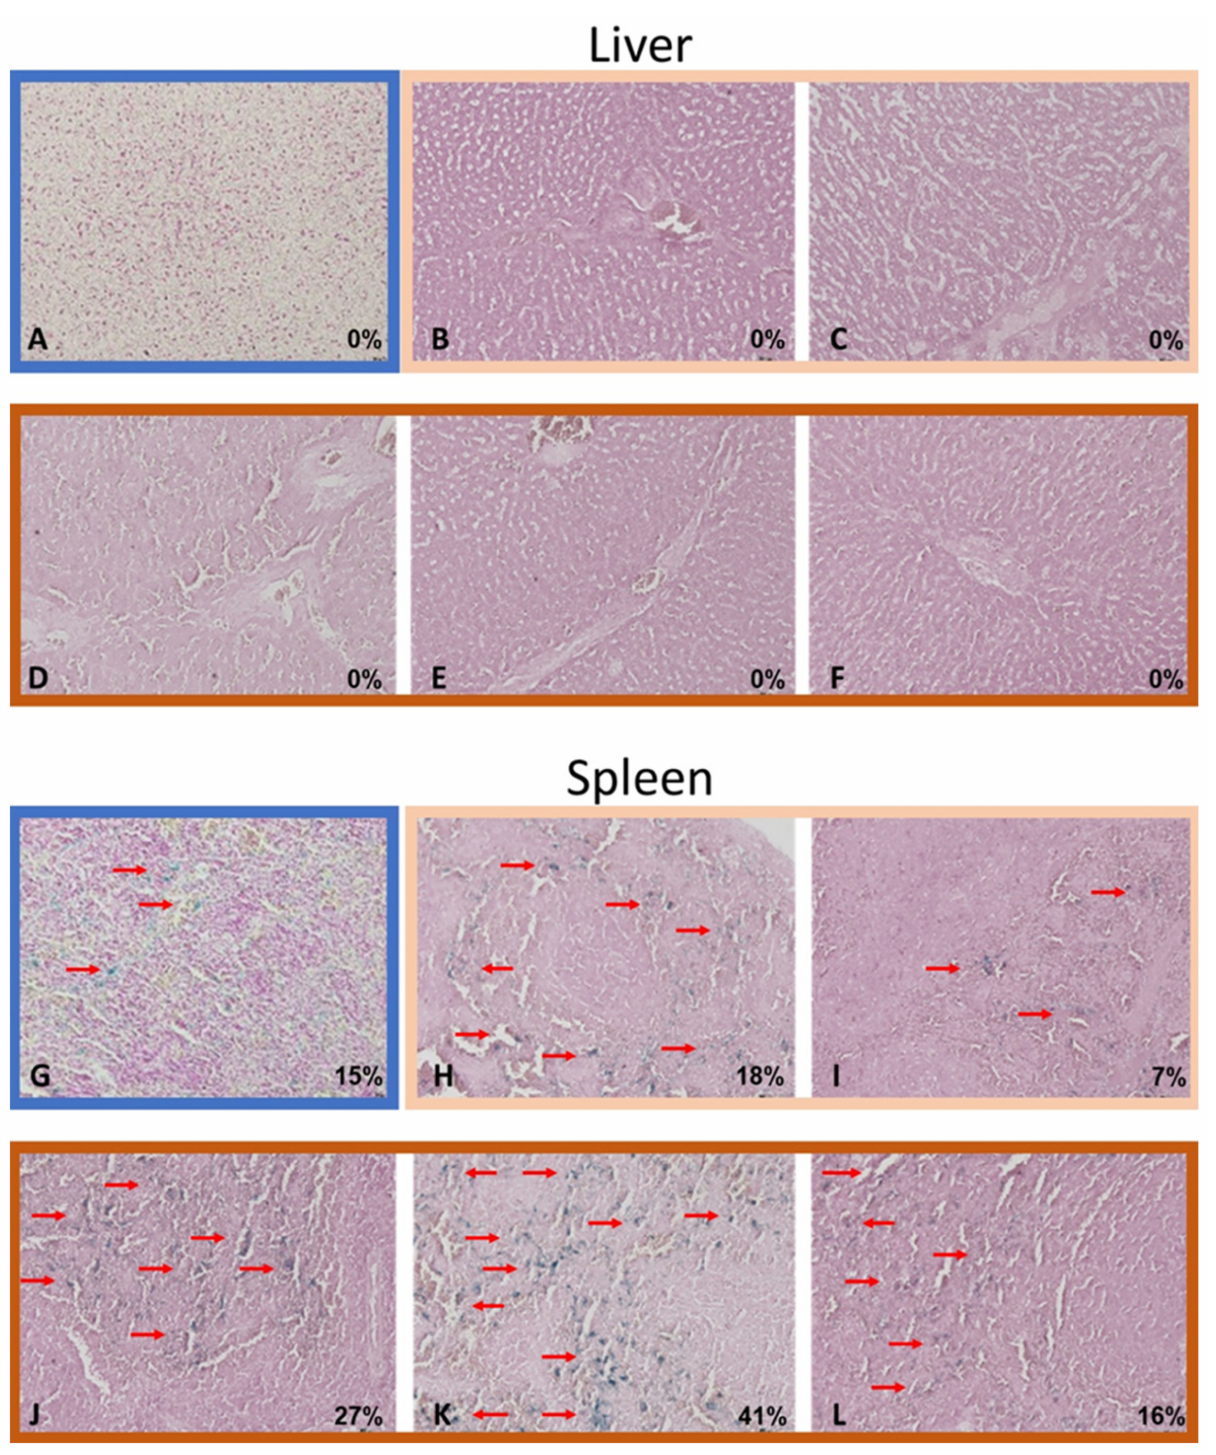
Figure 9. Prussian blue staining of the liver ( A – F ) and spleen ( G – L ). The specimens were obtained from the polymer SA group ( A , G ), iron SA_2 helix group ( B , C , H , I ), and iron SA_3 helix group ( D – F , J – L ), respectively. Red arrows indicate identified iron stain clusters. Magnification: 200 ×